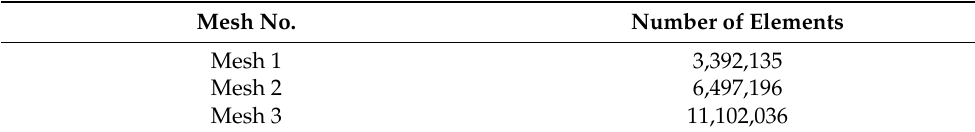
Table 1. Mesh information. Mesh No.